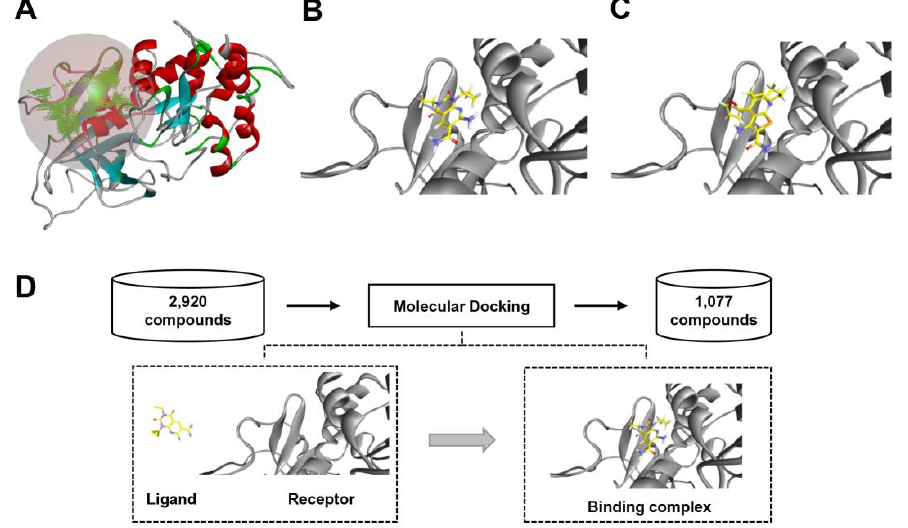
Figure 4. Molecular docking to screen chemicals interaction with eEF2K. ( A ) The defined inhibitor binding site to eEF2K protein, indicated by the circle. ( B , C ) The position of A484954 ( B ) and Com- pound 34 ( C ) in the binding pocket of eEF2K. ( D ) The work flow of molecular docking. Table 3. Top 10 purchasable chemicals obtained by molecular docking.